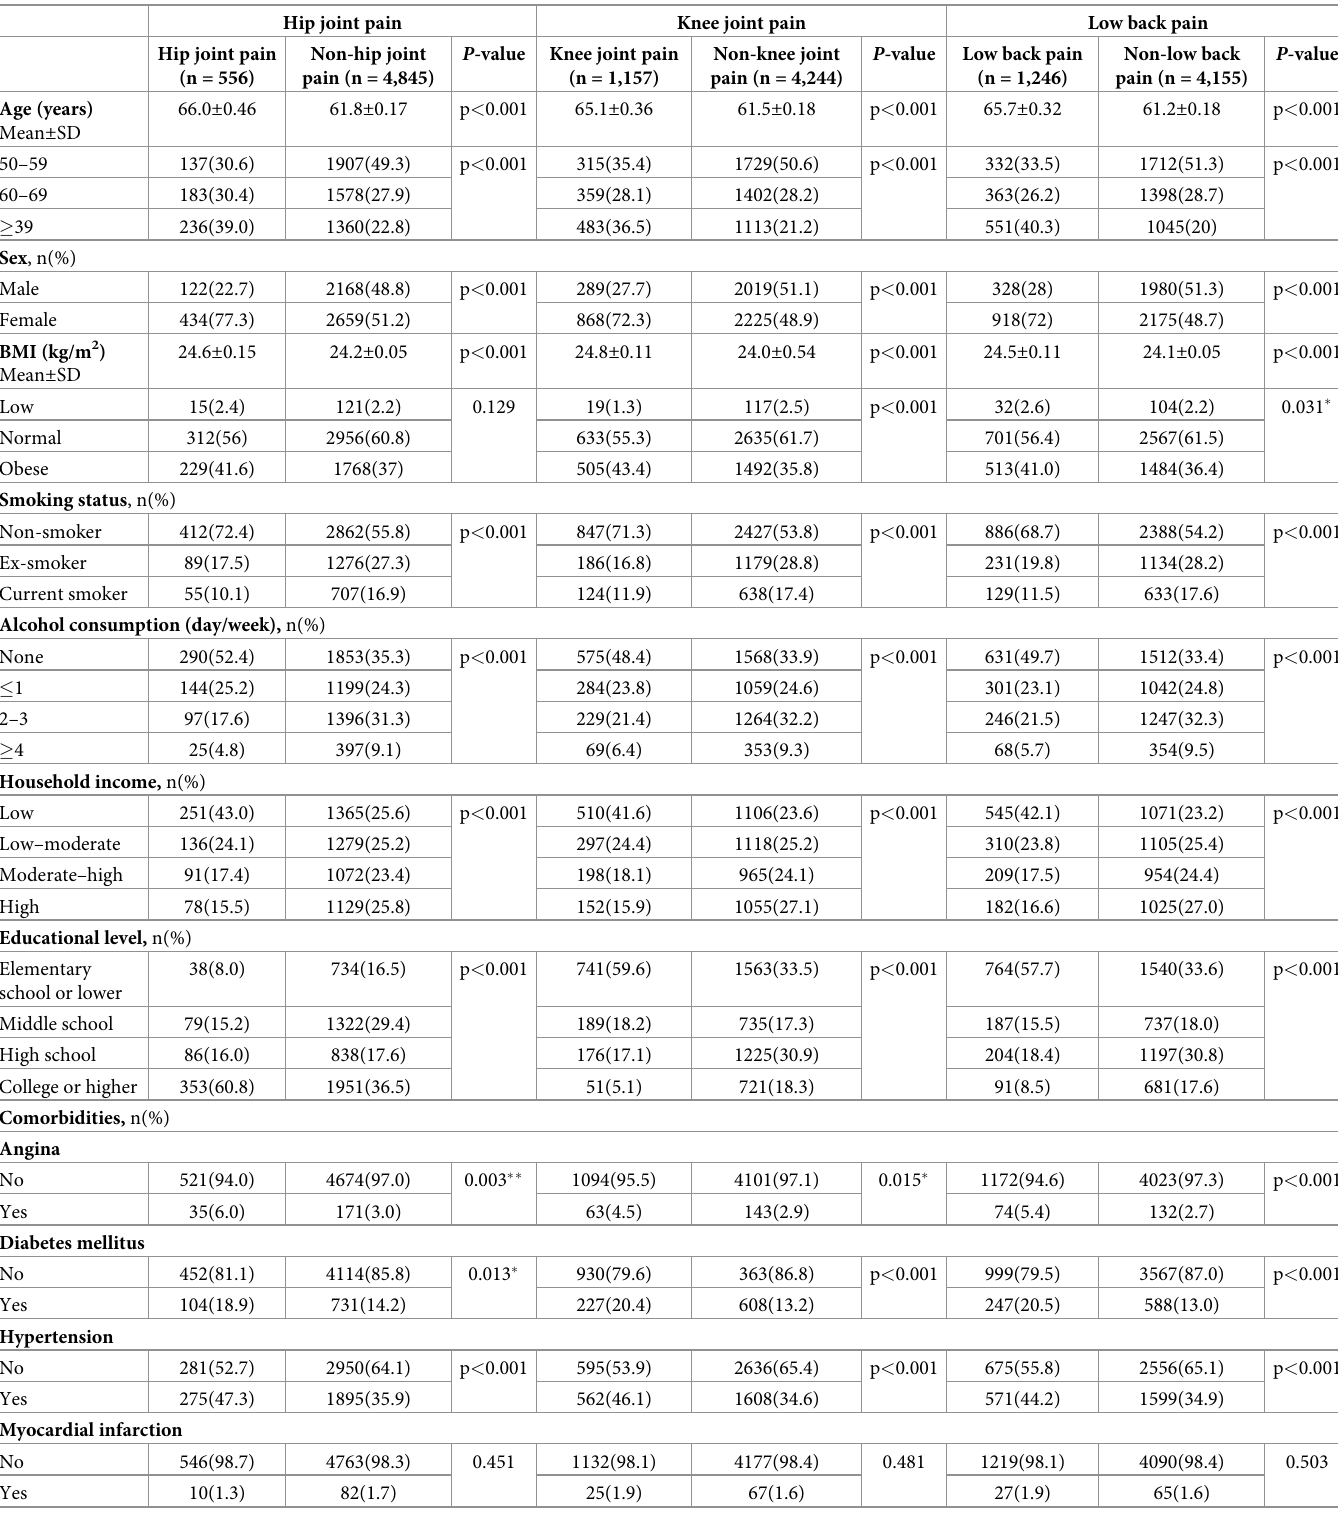
Table 1. Characteristics of the study subjects according to the osteoarthritis pain